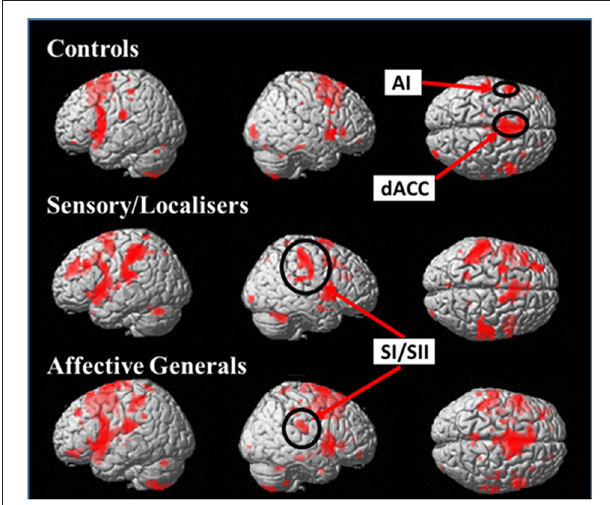
FIGURE 3 | Images display within group effects for Pain > No-Pain contrasts for each of the groups. Contrasts use a whole brain p < 0.001 (uncorrected) with a cluster extent threshold of k = 10 (the more liberal statistical threshold has only been used for figure display). All groups display increased activation in affective pain matrix regions (dACC + AI) but only S/L and A/G responders show effects in the primary and secondary somatosensory cortices.